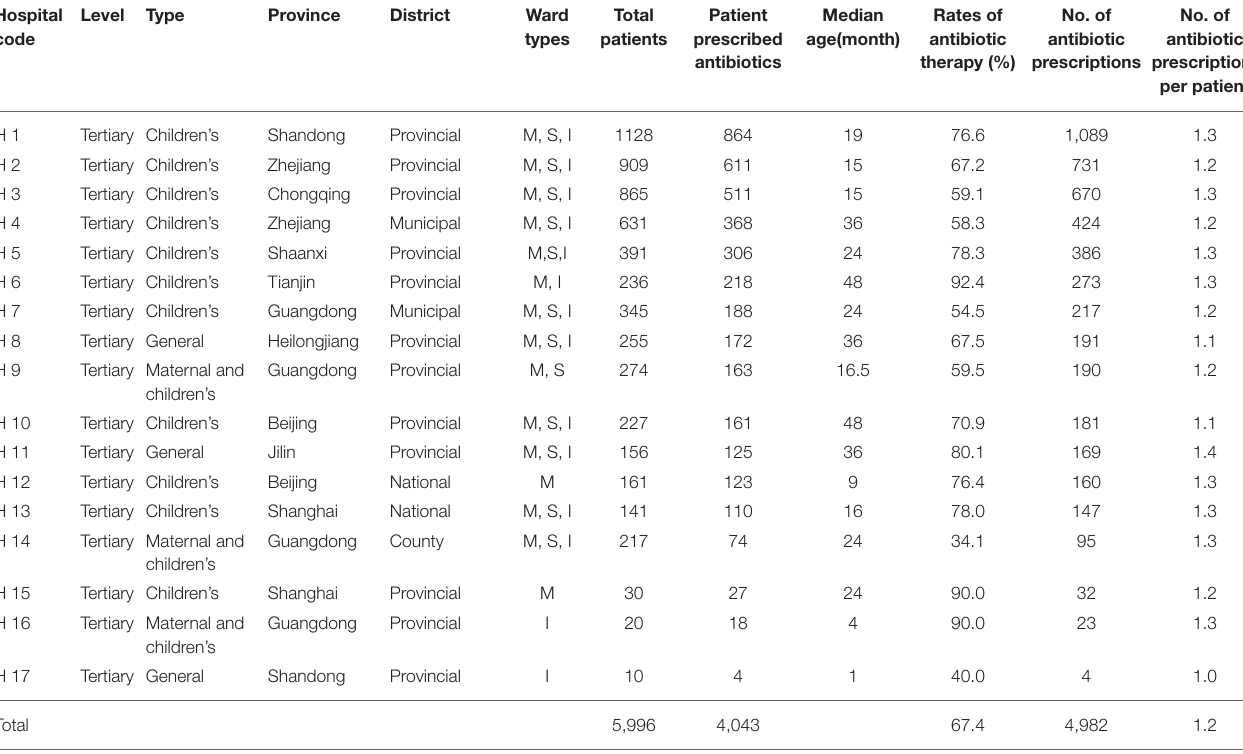
TABLE 1 | The characteristics of participating hospitals by frequency of 4,982 antibiotic prescriptions from 2017 to 2019. Hospital